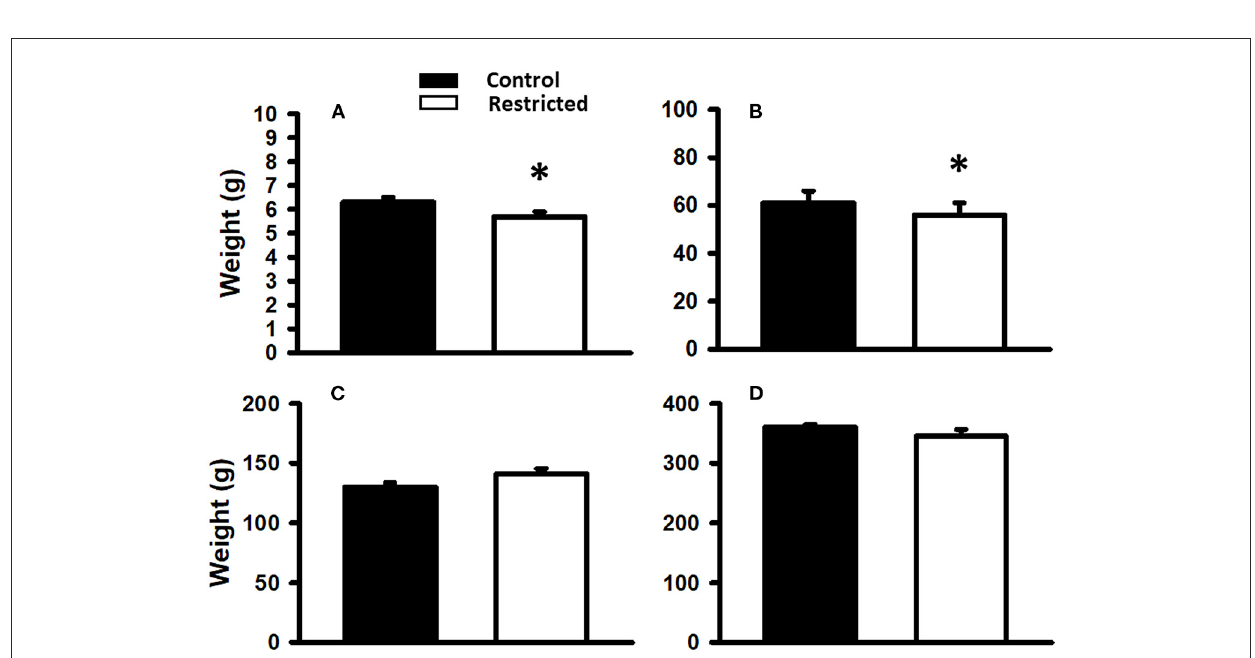
FIGURE2 Body weight of offspring from mothers fed a control diet and protein-restricted diet at birth (A) , weaning, PND21 (B) , PND36 (C) , and PND 110 (D) . Data are expressed as the mean ± SEM from 8 to 10 rats/group. * P < 0.05 compared with